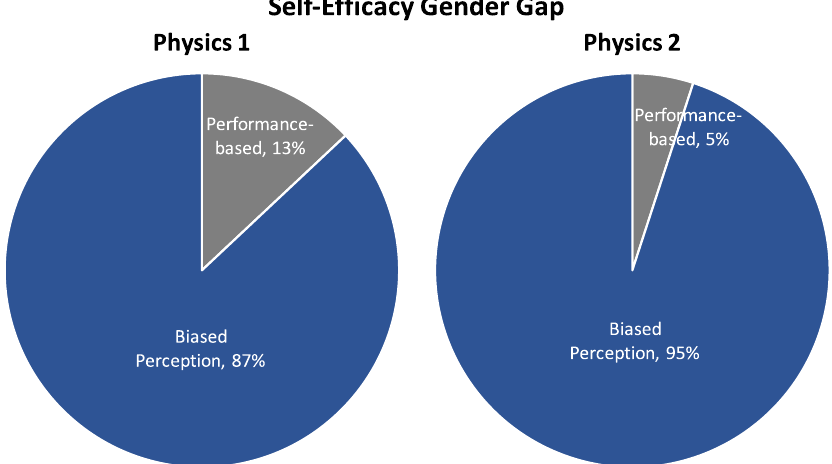
FIG. 3. The relative contributions of performance and biased perception to the post-self-efficacy gender gap in each course.